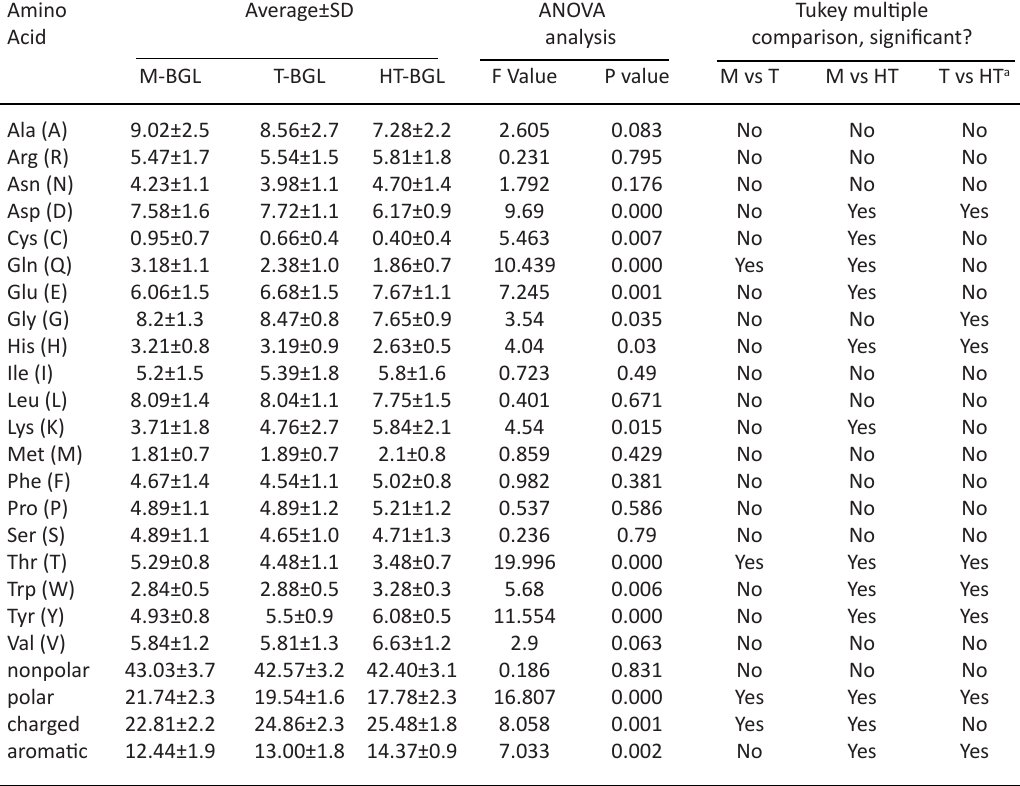
Table 5. Statistical analysis of amino acids composition (%) of GH1 β -glucosidases Amino Average±SD ANOVA Tukey multiple Acid analysis comparison,